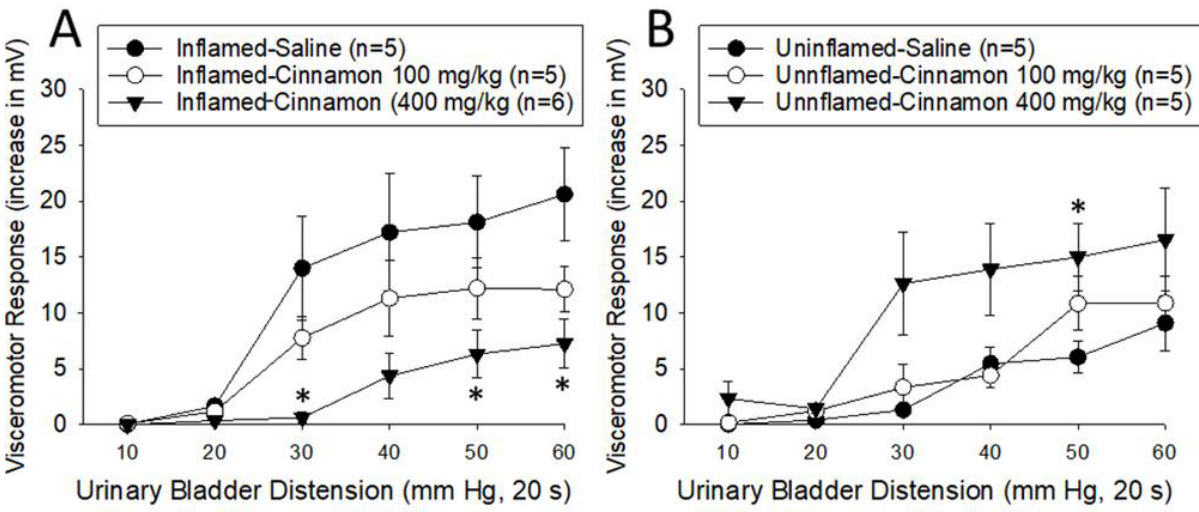
Figure 3. Dose-dependent effects of oral cinnamon on visceromotor responses to UBD in rats with inflamed bladders ( A ) and uninflamed bladders ( B ). An inhibitory effect was noted in rats with cystitis and an augmentation effect was noted in otherwise healthy rats. * indicates a significant difference from the saline-treated rats ( p <